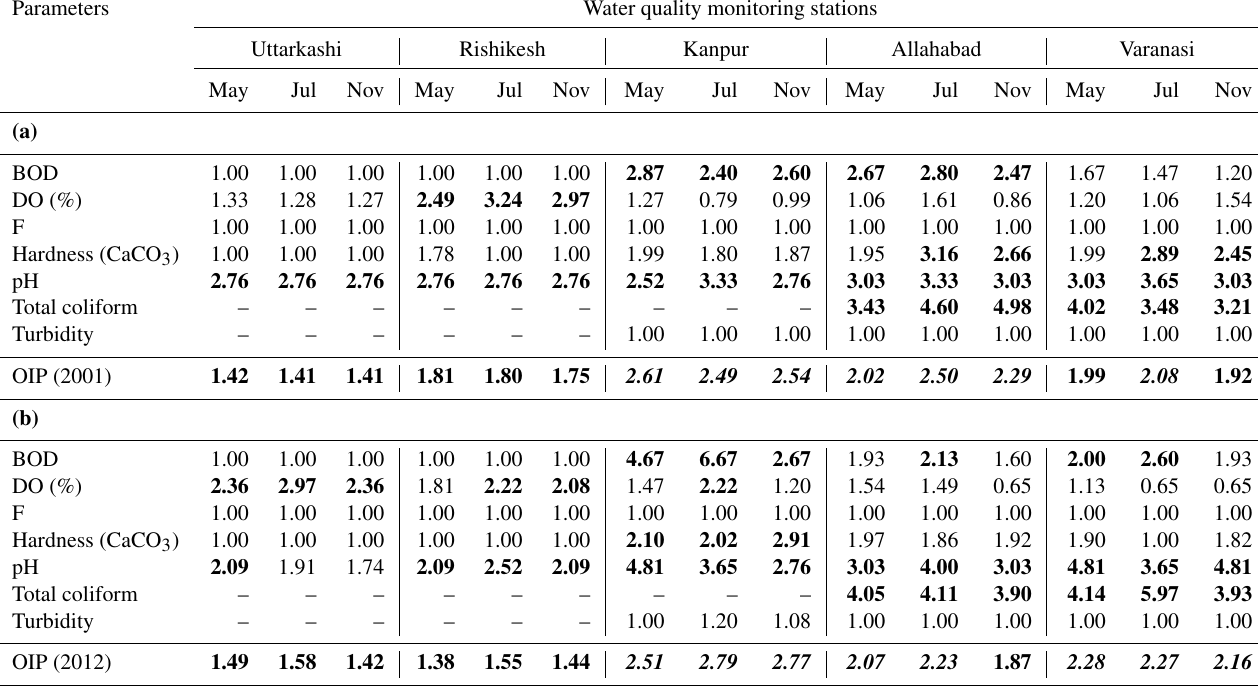
Table 9. Individual parameter indices (IPIs) and overall indices of pollution (OIPs) computed at various water quality monitoring stations of the Upper Ganga River basin over periods of 2001 and 2012 for premonsoon, monsoon and postmonsoon seasons. Bold IPI and italic OIP values are